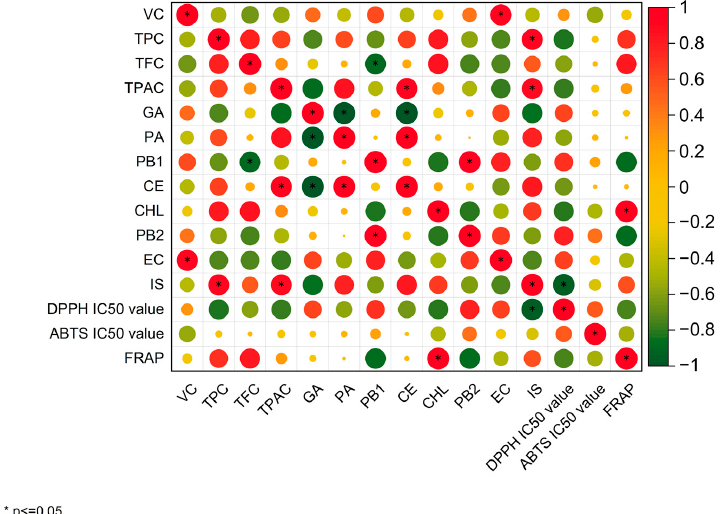
Figure 4. Pearson correlation matrix among Vc, phenolics, and antioxidant activity. The correlation coe ffi cients are proportional to the circular size and color intensity. The positive correlation is displayed in orange, and negative in green. * shows signi fi cant correlation at p < 0.05.